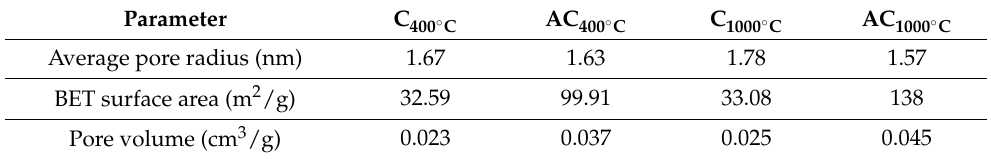
Figure 7. FTIR analysis for neat and loaded ( a ) AC 400 ◦ C MB-0.3:1 and ( b ) AC 1000 ◦ C MB-0.3:1. Table 1. Adsorption characteristics for carbon samples before and after activation